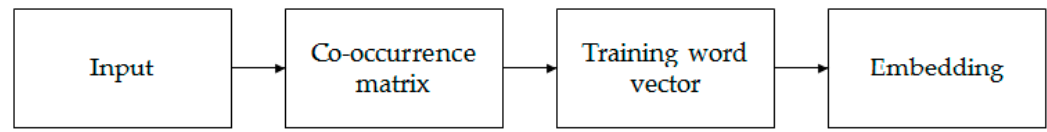
Figure 2. The process of embedding stage. Input all the k -mer sequences obtained in the previous stage, calculate the co-occurrence matrix for the entire k -mer corpus and get the embedded vector after training.